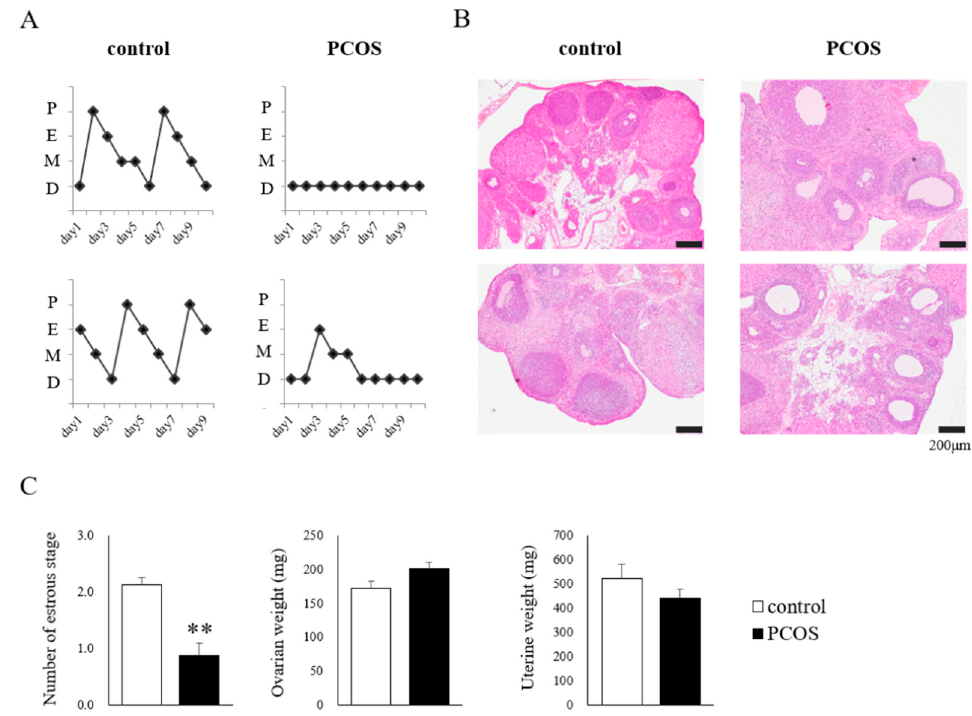
Figure 2. ( A ) The estrous cycle of two representative rats: D, diestrus; M, metestrus; E, estrus; P, proestrus. ( B ) Representative ovarian morphology. ( C ) The number of estrous stages, ovarian weight, and uterine weight in the PCOS ( ■ ) and Control ( □ ) groups. Data are expressed as the means ± SEM. ** p < 0.01.